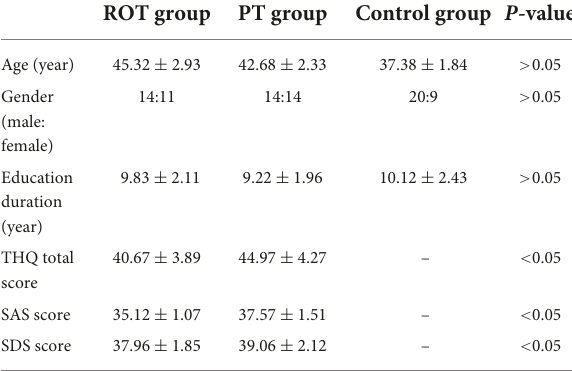
TABLE 1 Subject characteristics of the ROT, PT, and control